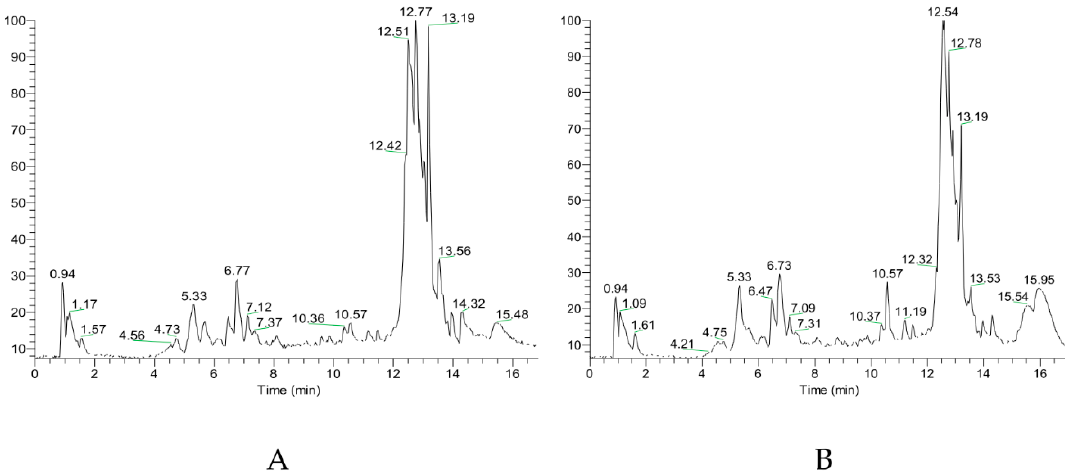
Figure 1. Total ion current chromatogram of UHPLC: ( A ) total ion current chromatogram of samples treated by abscisic acid and ( B ) total ion current chromatogram of control group samples.